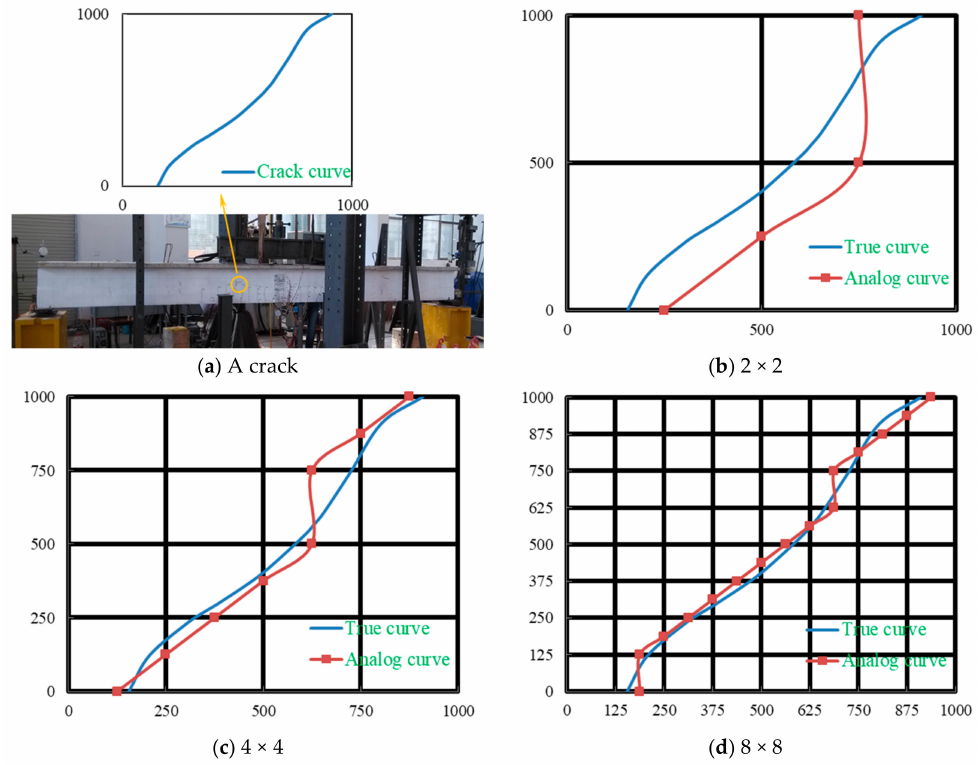
Figure 14. ( a ) A crack on the surface of a concrete beam; ( b – d ) Simulation results of the crack using composite mesh film sensors (CMFSs) with di ff erent sensing element (SE) distribution